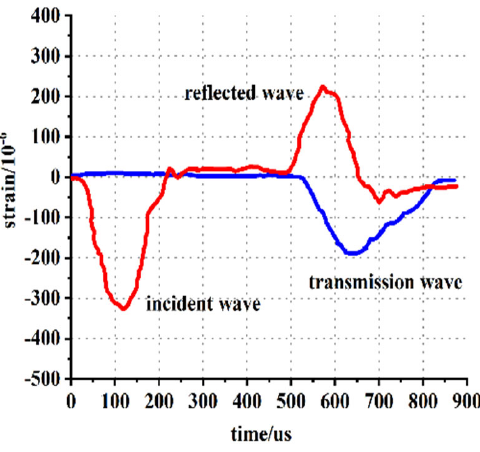
Figure 7. SHPB three − wave strain time − history curve.